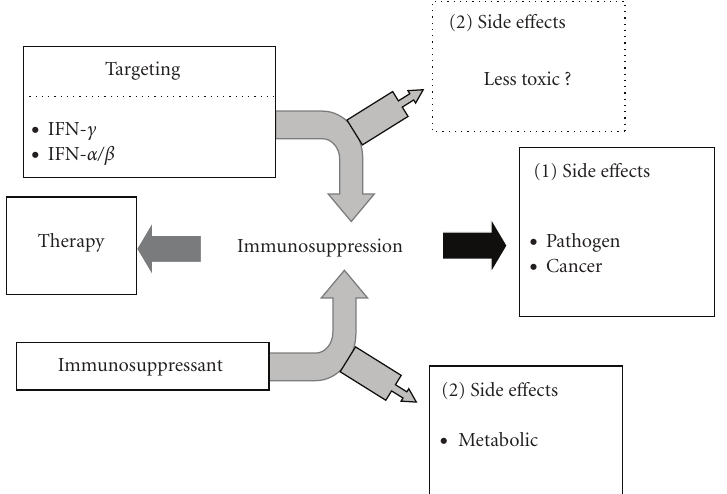
Figure 5: Cytokine targeted therapy will be expected to clinical application, but more detailed examination of side e ff ects (e.g., development of infections, cancer, allergic diseases, and autoimmunity) is required. Clinical application to lupus must be based on their safety profile, adverse e ff ects, risks, and advantages. Likewise, in this analysis we o ff er specific recommendations, based on evidence, for the best, is Th1/TH2 balance shift in vivo by using IL-4 gene